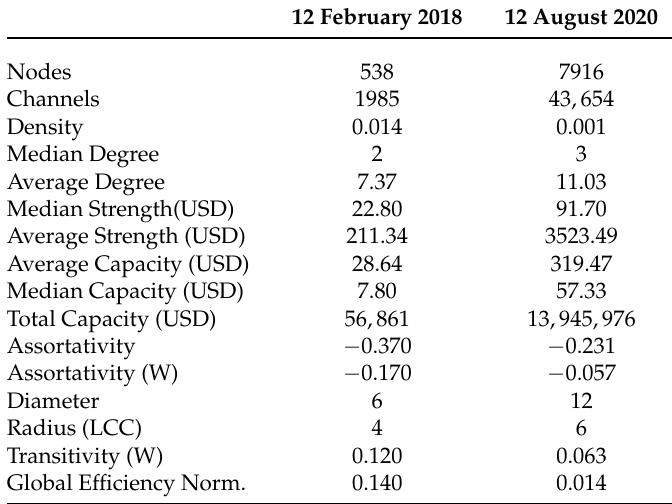
Table 1. A collection of topological measures for LN. This table presents some topological measures extrapolated from the network at its first and last observation in our sample